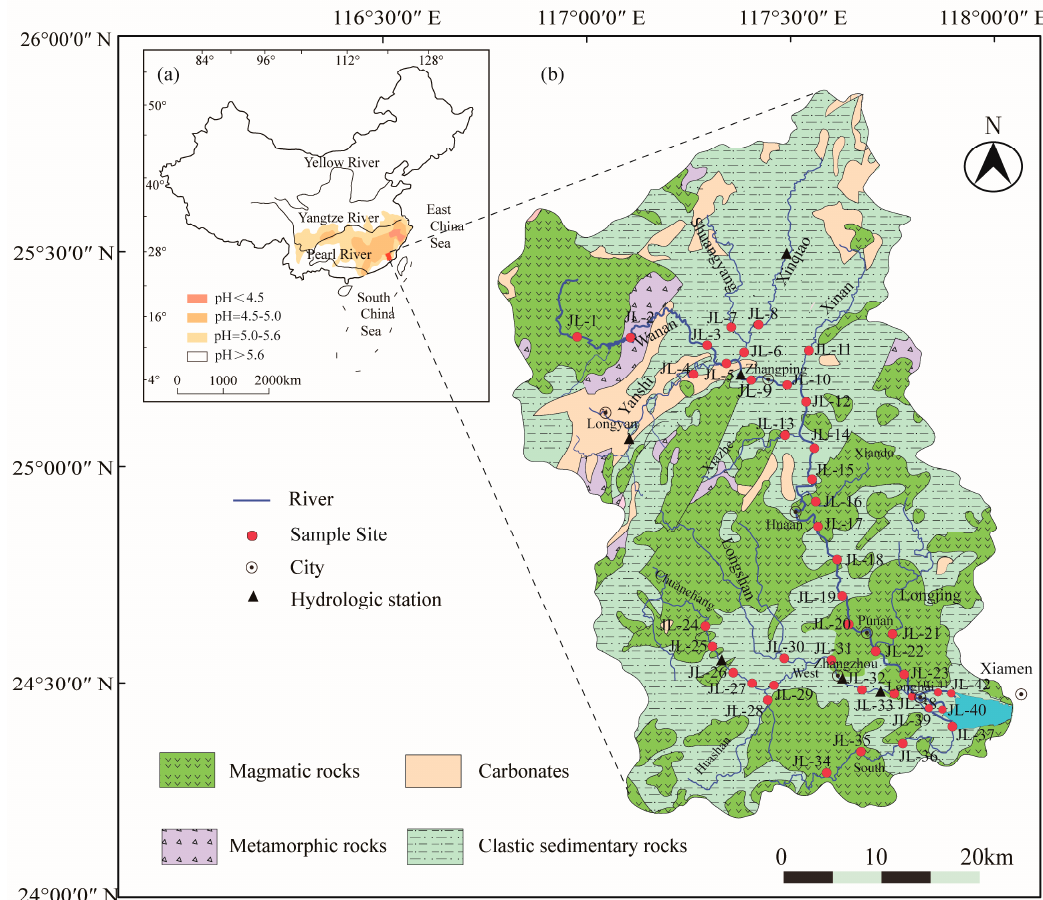
Figure 1. ( a ) The People’s Republic of China with the location of Jiulongjiang River basin (JRB). ( b ) Simplified geological map of the JRB with sampling sites. JL-1 to JL-42 represent the number of 42 water sampling sites in the Jiulongjiang River (JR).